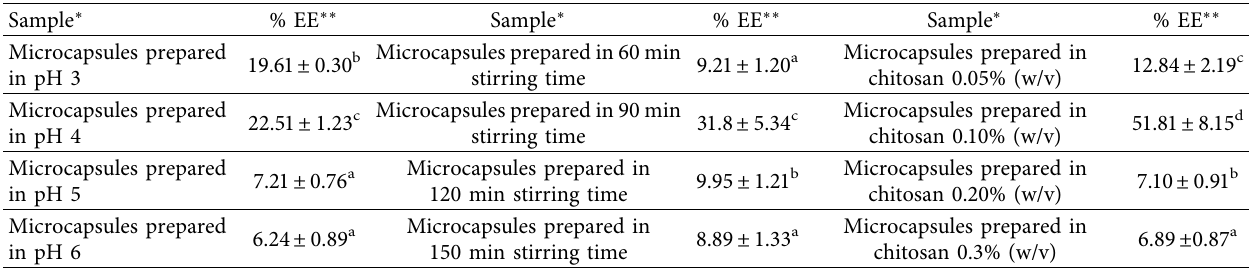
Table 1: Encapsulation efficiency of microcapsules of R . tuberosa L. prepared in various pH, stirring time, and chitosan concentration.